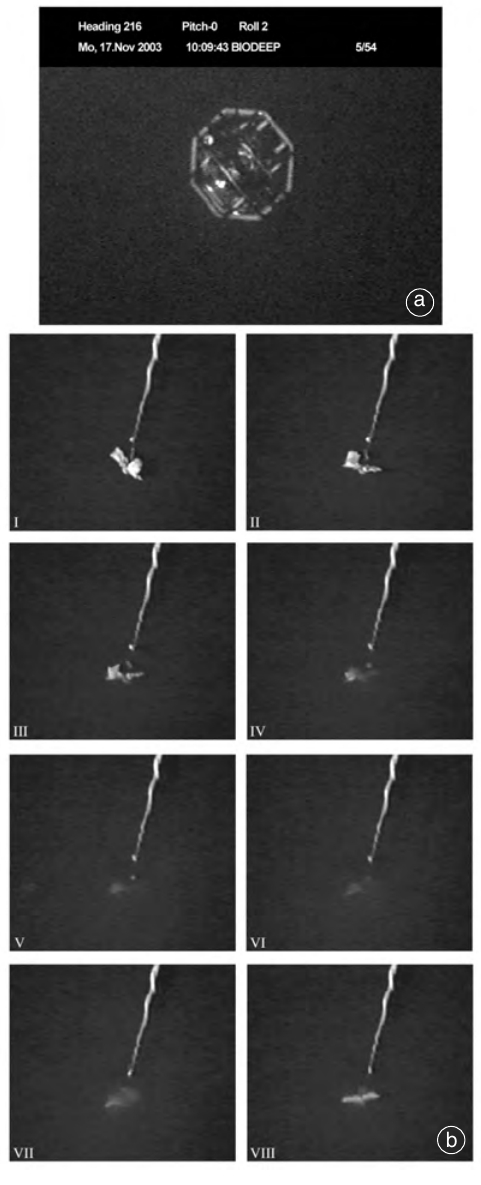
Fig. 6a,b. Images of the interface as seen by MO- DUS: a) view from MODUS to the suspended SCI- PACK (10 m mechanical cable) right before entering the Urania Basin; b) sequence of the survey at the interface of L’Atalante (10 m cable): iron ball and flag approach- ing the interface (I-III), entering the brines (IV), laying below the interface (V-VII) and coming out